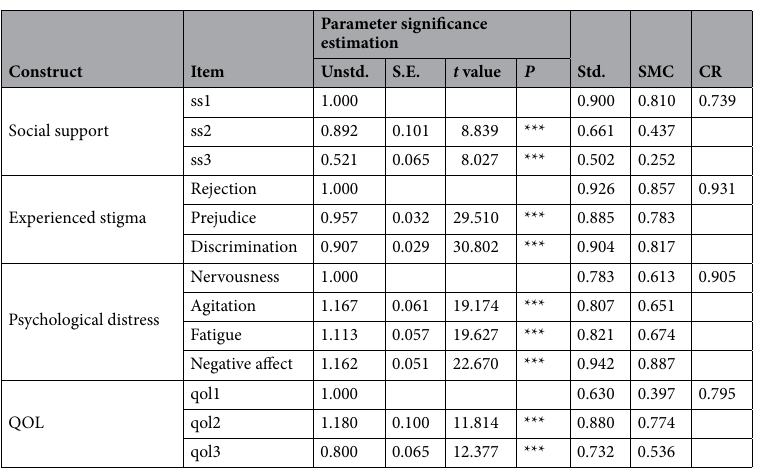
Table 3. Reliability analysis of the constructs. Three items of the Oslo social support scale are labelled ss1, ss2, and ss3. Three categories of the QOL scale are labelled qol1, qol2, and qol3. QOL quality of life, Unstd. unstandardized estimate, S.E. standard error, Std. standardized estimate/factor loading, SMC squared multiple correlations, CR composite reliability. *** P < 0.001.